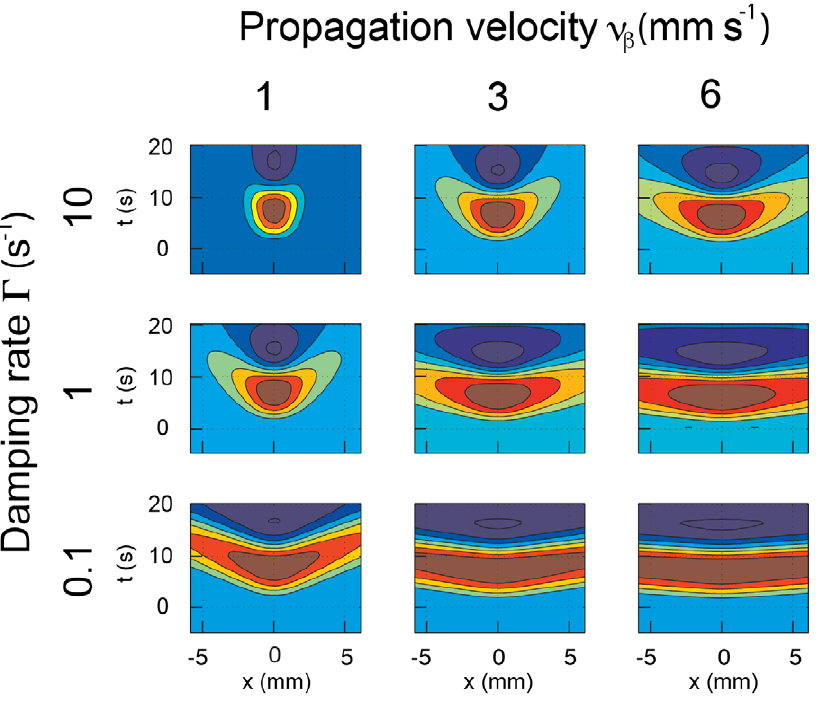
Figure 2. Predicted responses vs. x and t for a range of physiologically plausible values of of n b and C . Each column represents a particular n b – as labeled at the top, while each row corresponds to a different C – as labeled at the left. concentric rings at eccentricities of 0.6 u , 1.6 u , and 3 u ( Figure 3A ).